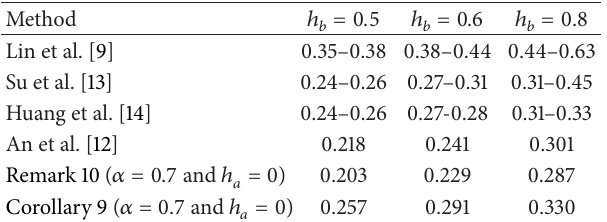
Table 1: Comparison with minimum performance level 𝛾 for various ℎ 𝑏 ( ℎ 𝑑 = 0.2 ).